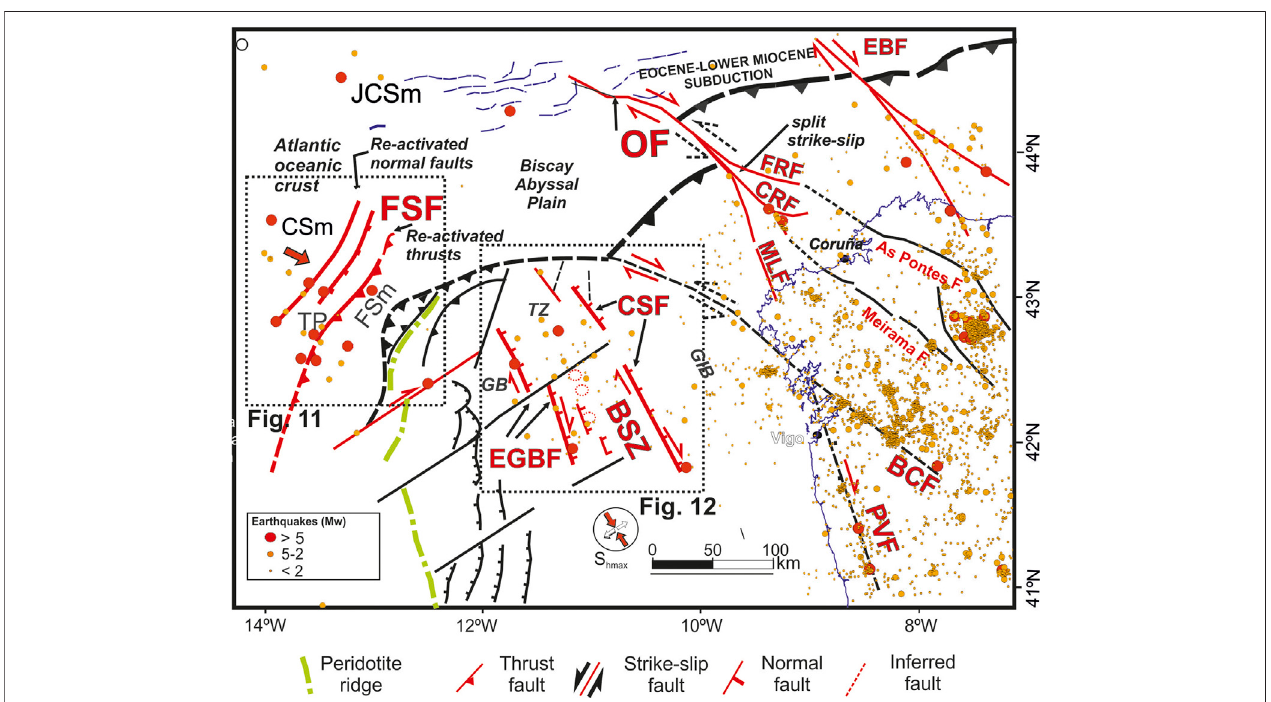
FIGURE10| Mainactivesubmarinefaults(redlines)and distribution ofearthquakes intheNorthwesternIberiaMargin. Theseactivesubmarine faultsarerelated to re-activation of former structures in response to present-day NW-SE convergence. (A) Reactivation of the Finisterre thrust fault (FSF); (B) The Burato Shear Zone (BSZ), an area of tension gashes and craters bounded by NNW-SSE normal to strike-slip faults (CSF: Castelao Fault); and (C) NW-SE strike-slip faults: Ortegal Fault (OF) split into three strike-slip faults inthe margin (MLF: Malpica Fault, CRF:CoruñaFault and FRF:FerrolFault) and twomain faults onshore (As Pontesand Meirama faults); and Estaca de Bares Fault (EBF). Onshore faults: Padrón-Vigo Fault (PVF) and Becerreá Fault (BCF) a highly seismic zone. Earthquakes location taken from the online database of the Instituto Geográ fi co Nacional (IGN). Faults are also listed in Table 1 . Other labels same than Figure 9 .